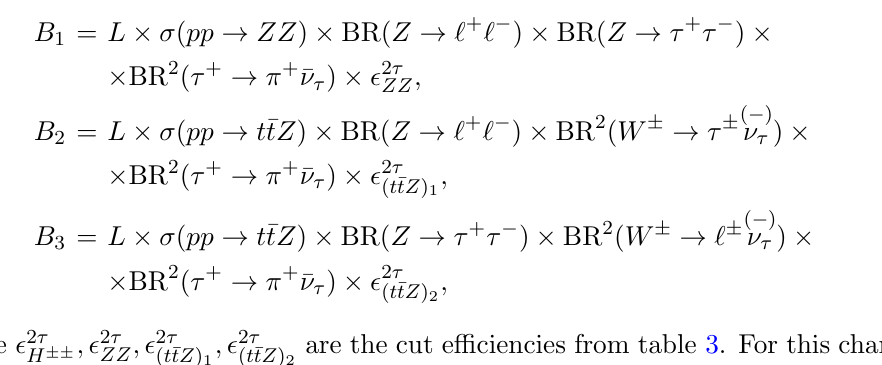
and those for backgrounds